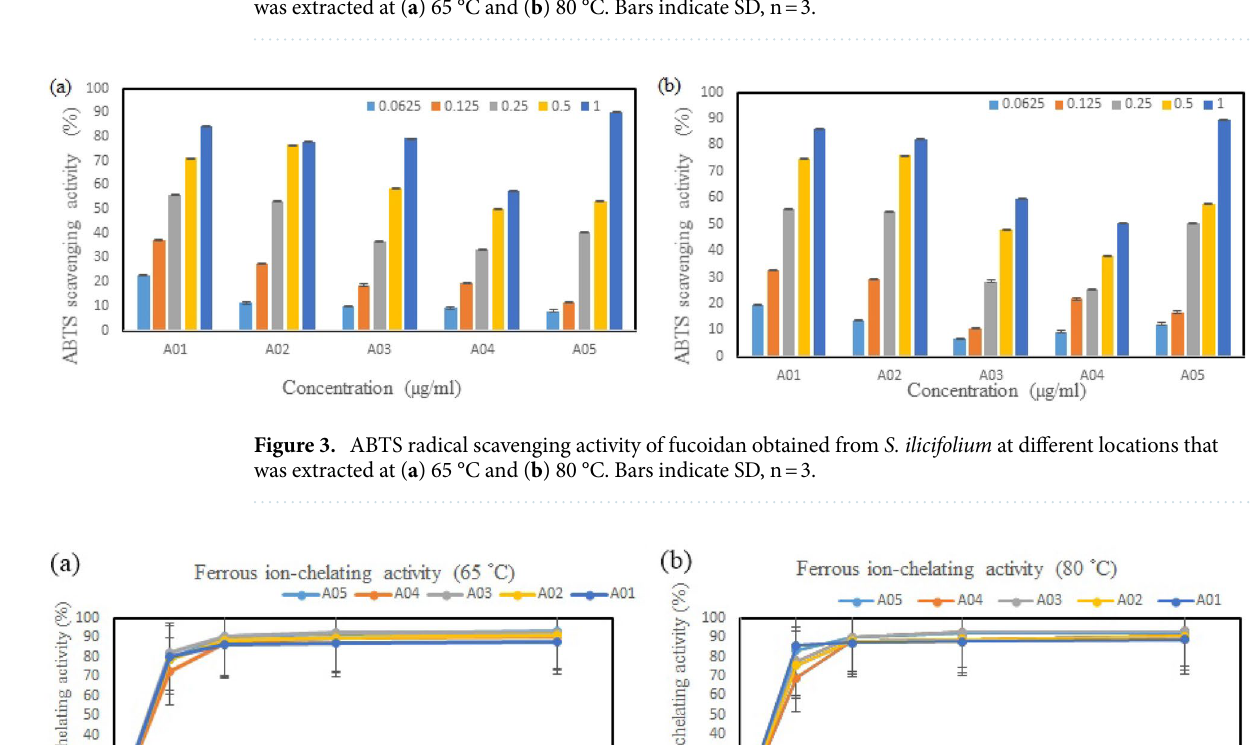
Figure 2. DPPH radical scavenging activity of fucoidan obtained from S. ilicifolium at different locations that was extracted at ( a ) 65 °C and ( b ) 80 °C. Bars indicate SD, n = 3.